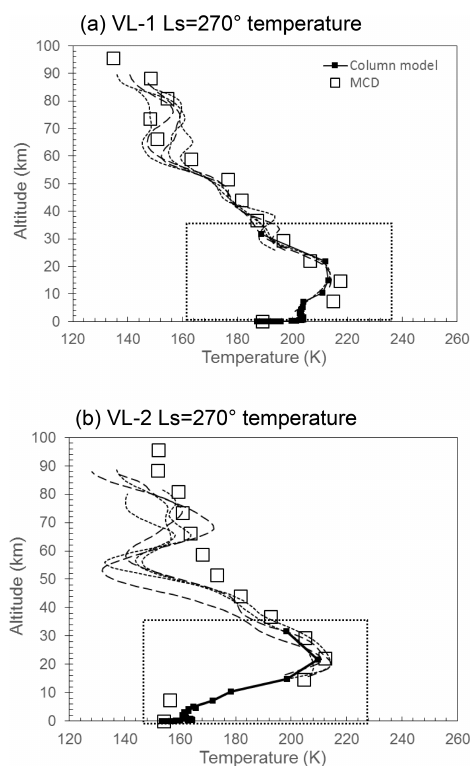
Figure 8. Fit of the column model to the soundings at L S = 270 ◦ using the adjustment for adiabatic heating found in Sect. 3. For the boxes in each figure please refer to Fig.